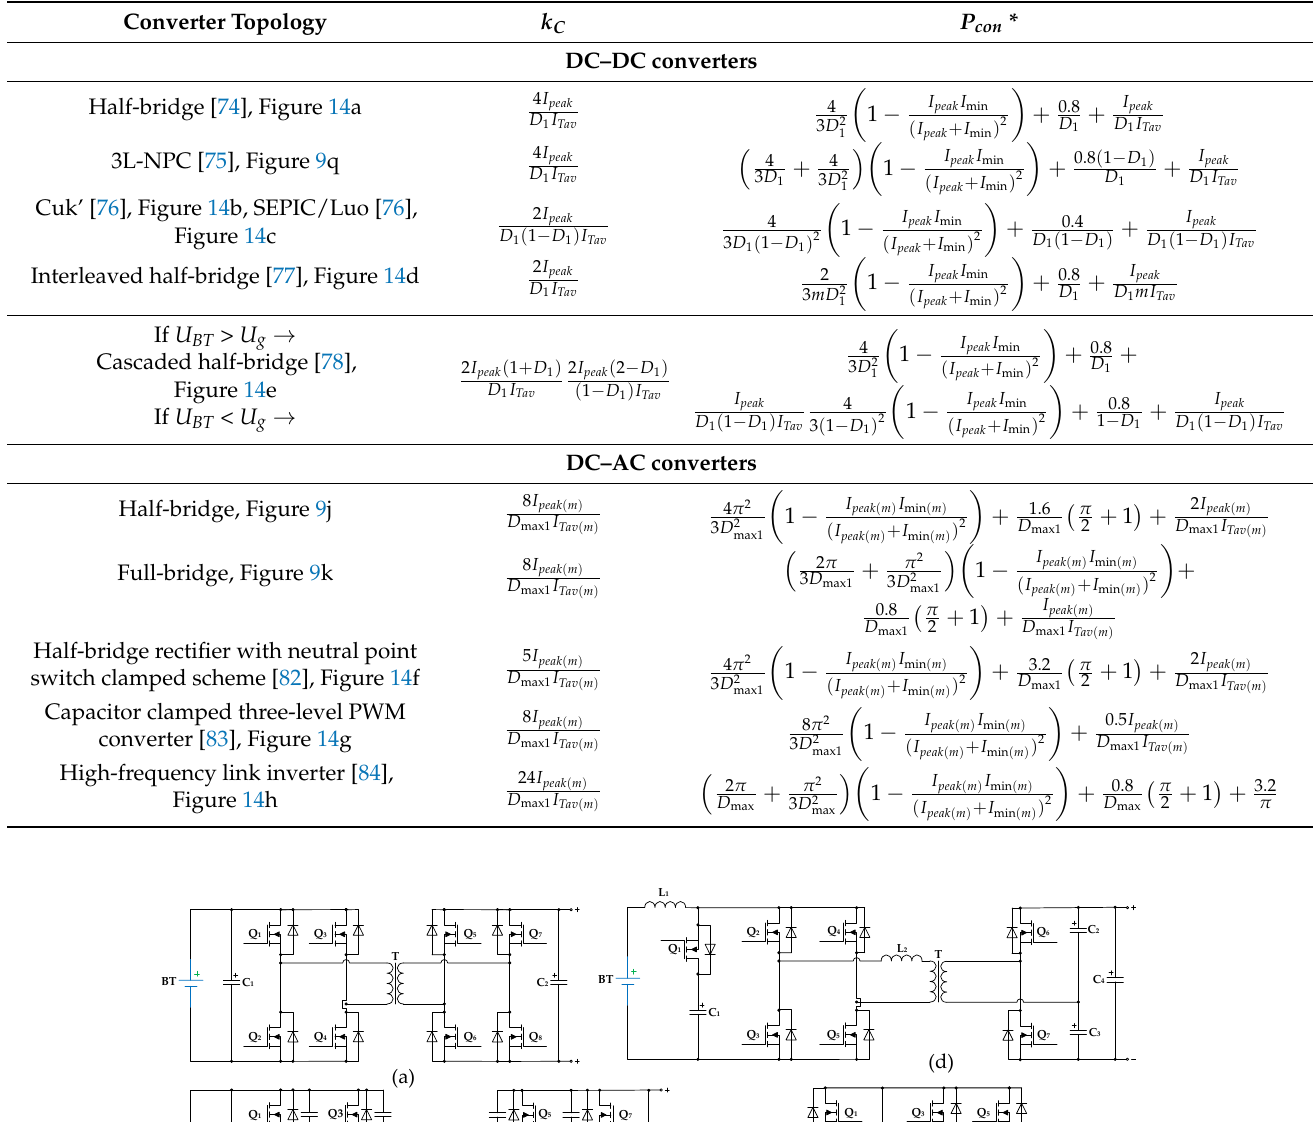
Table 6. A Comparative analysis of single-stage energy storage converter effectiveness.